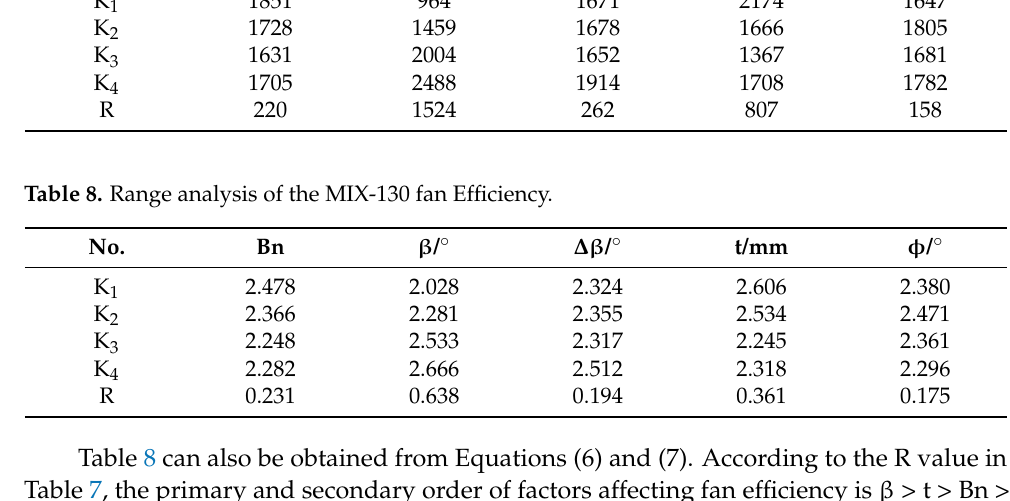
Table 7 can be obtained from Equations (6) and (7). According to the R-value in Table 8,